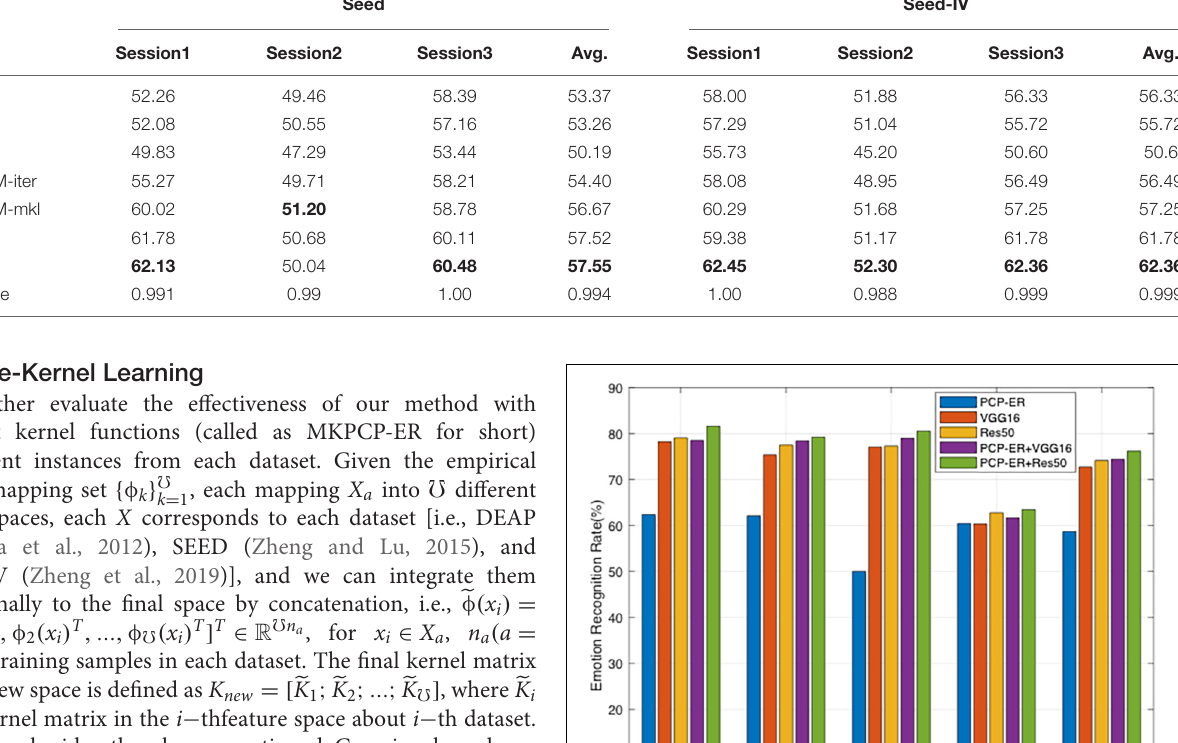
TABLE 5 | Performance comparison among PCP-ER and the latest methods on SEED and SEED-IV datasets. Methods